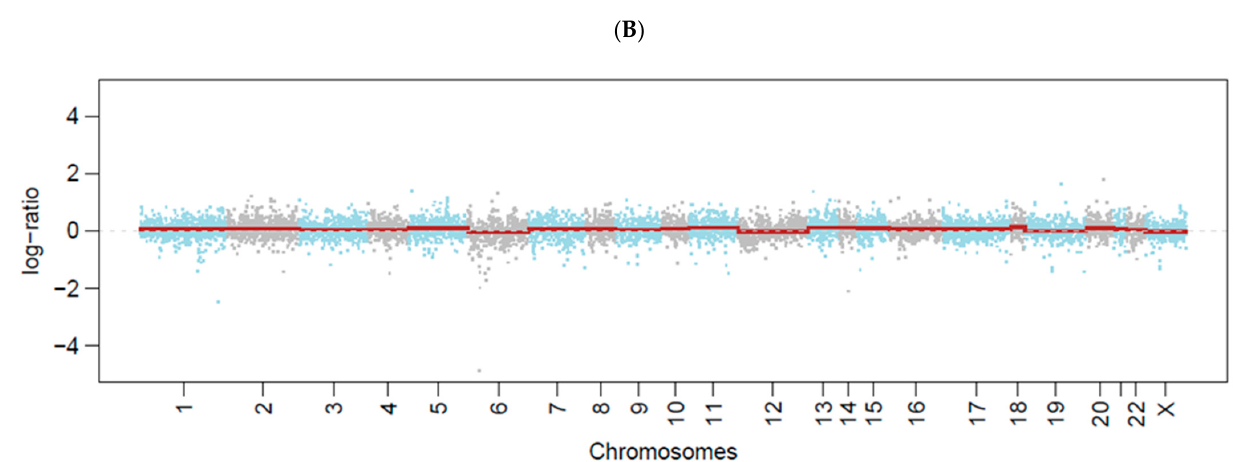
Figure 3. Copy number analysis of cell-free DNA (cfDNA) extracted from plasma collected before ( A ) and after ( B ) treatment with ribociclib plus letrozole. Amplification of the CCND1 gene in chromosome 11 (arrow) was detected at baseline before treatment, but not after therapy.